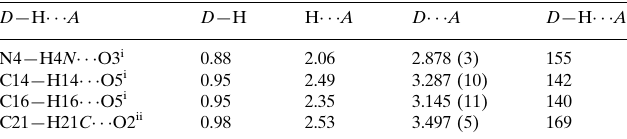
Hydrogen-bond geometry (A ˚ , (cid:5) ).